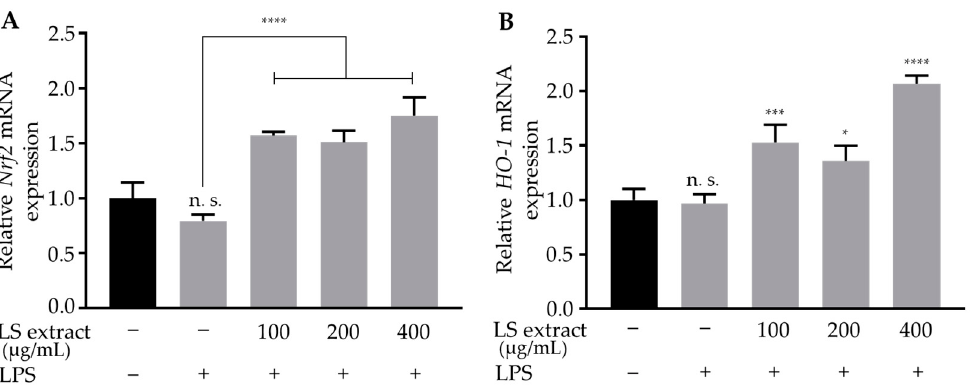
Figure 8. E ff ects of LS leaf extract on the expression of transcription factor nuclear factor-erythroid-2-related factor ( Nrf2 ) ( A ) and phase II enzyme heme oxygenase-1 ( HO-1 ) ( B ) in LPS-stimulated RAW 264.7 cells. Cells were pretreated with LS leaf extract for 24 h, followed by LPS (1 µ g / mL) stimulation for 18 h. The expression of Nrf2 and HO-1 genes was analyzed by qRT-PCR ( n = 3). Values represent the mean ± SD. Statistical significance was calculated by t -test and one-way ANOVA. n. s., not significant; * p < 0.05, *** p < 0.001, and **** p < 0.0001 vs. cells treated with LPS only.